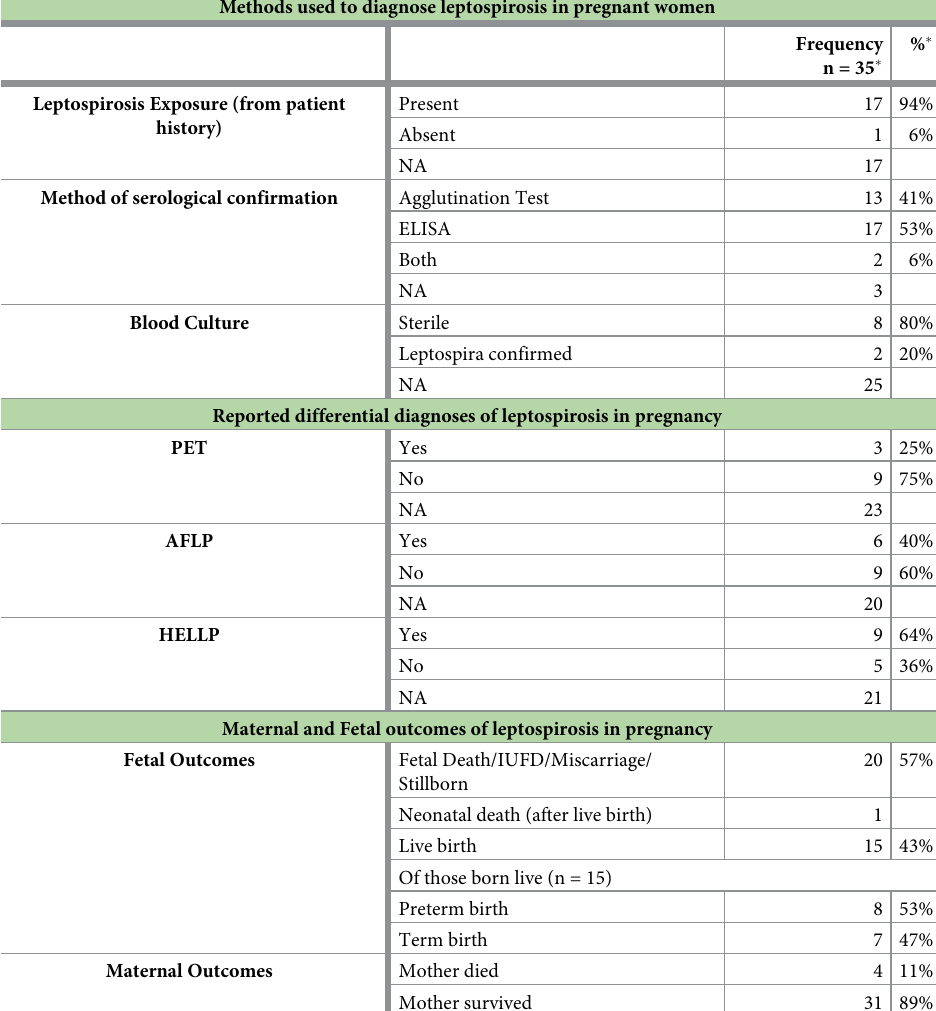
Table 6. Summary of diagnostics, differential diagnoses and outcomes reported for cases of leptospirosis in pregnancy. Methods used to diagnose leptospirosis in pregnant women